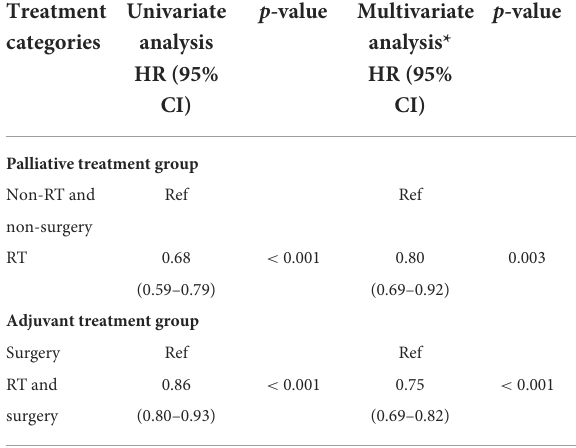
TABLE 3 Cox regression analysis for overall survival of the two treatment category